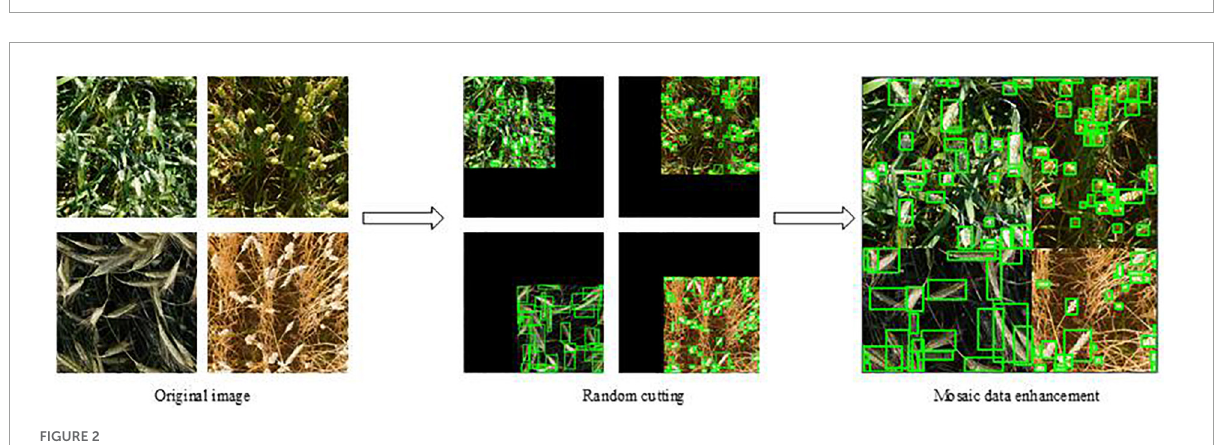
FIGURE1 Geographical location of the study area.